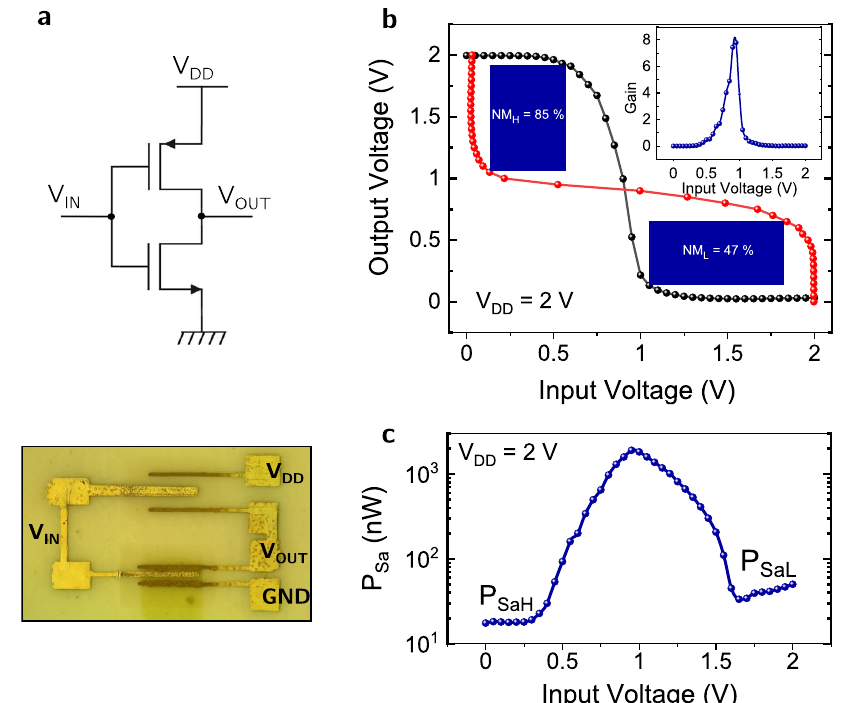
Fig. 2 Flexible complementary inverter on paper. a Electrical schematic and optical image of a complementary inverter made of a CNTs FET and a MoS 2 FET. b Voltage transfer characteristic (VTC, black line), and noise margin (red line) of the fl exible complementary inverter for V DD = 2 V. Inset, the voltage gain of the same CMOS inverter. c Power consumption of the complementary inverter for V DD = 2.0